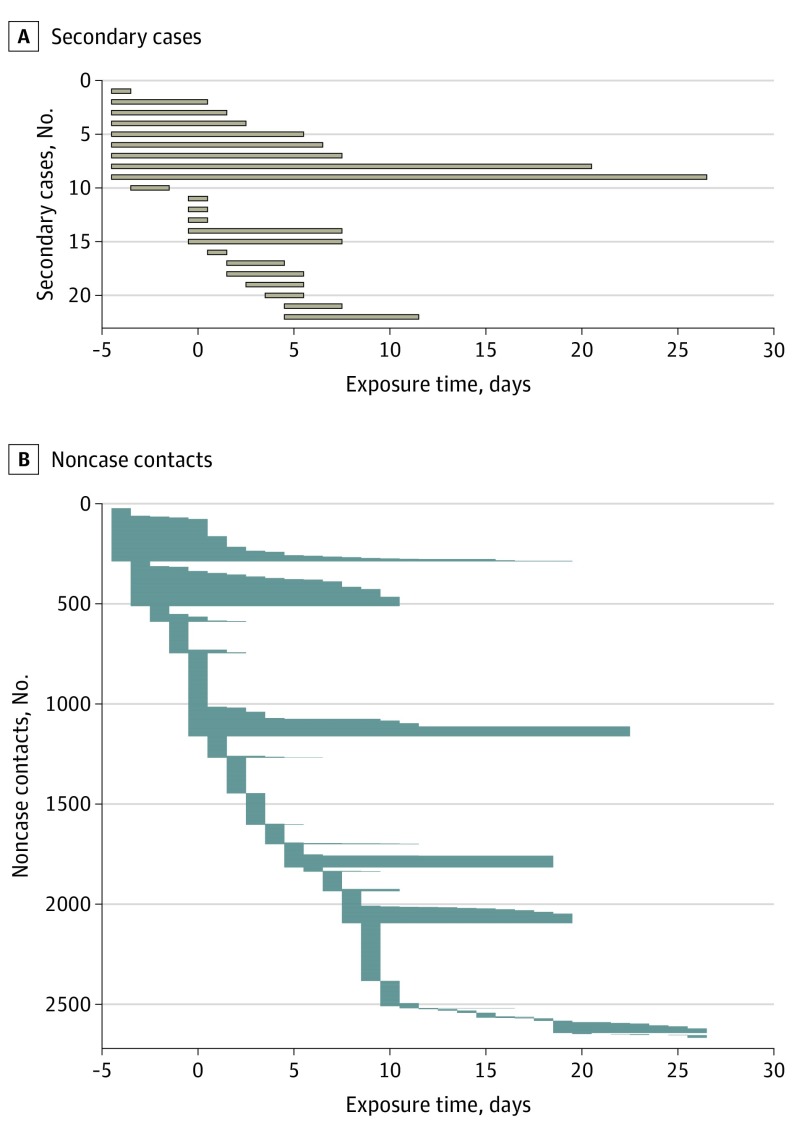
Exposure Window Period Among Secondary Cases and Noncase ContactsThe exposure time was defined as the period from the first day of exposure to the index case to the last day of exposure. Time zero indicates the day of symptom onset of the index case.